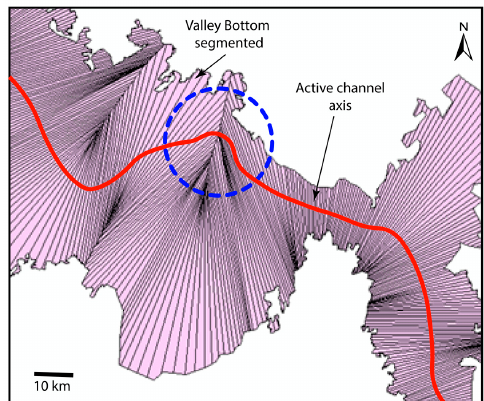
Figure A1. Example (blue, dotted circle) of a situation where the segmentation of the VB may create an inconsistency with a line SHP (e.g., the AC axis, red line): the line does not touch all segments because some of them do not cross the whole VB polygon. Therefore, the intersection line-segmented VB will not contain the same number of elements; but the identifiers of those remaining will be